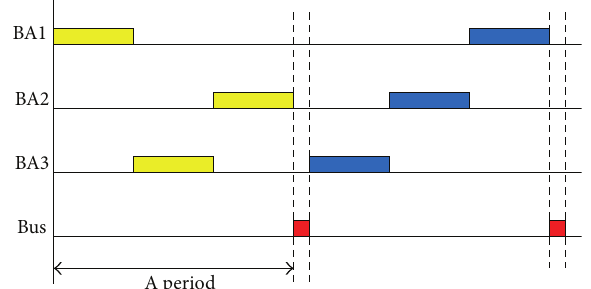
Figure 9: Timing diagram of the synchronous